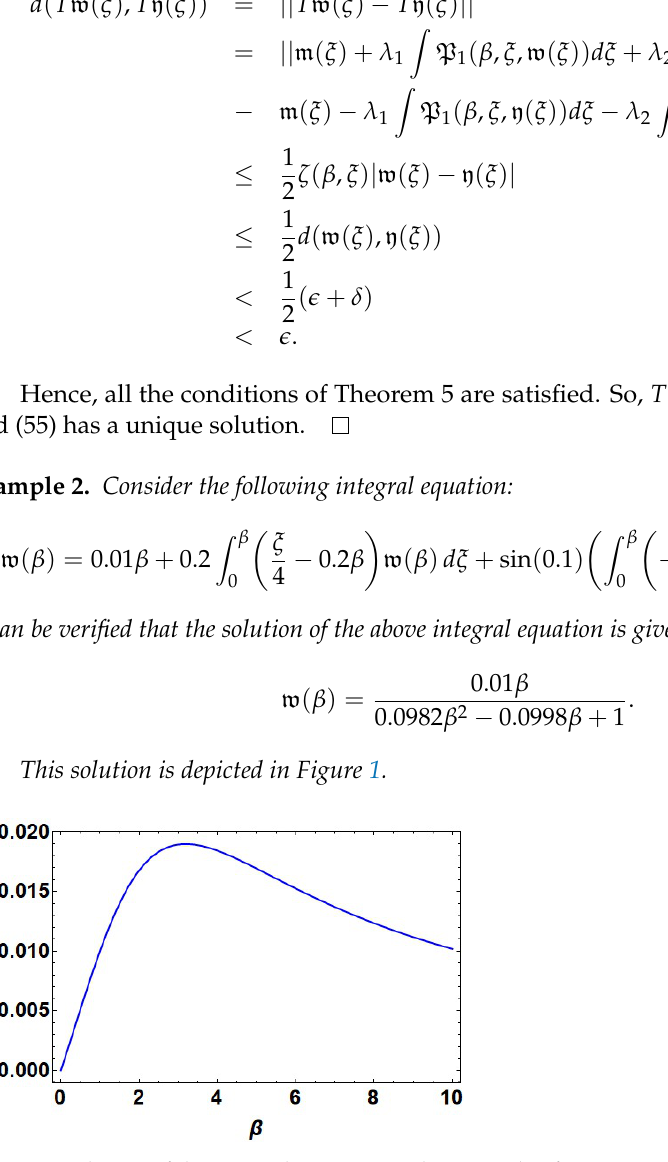
Figure 1. Solution of the integral equation in the example of Section